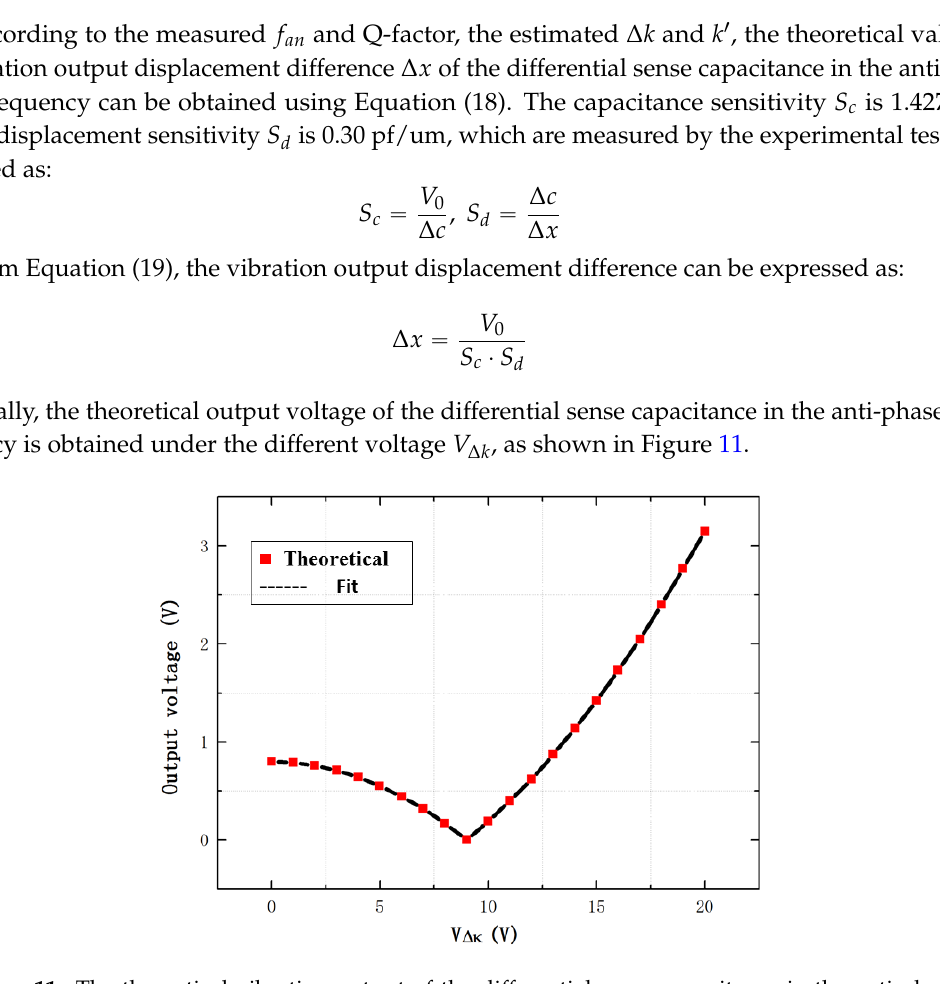
Figure 11. The theoretical vibration output of the differential sense capacitance in the anti-phase mode frequency.